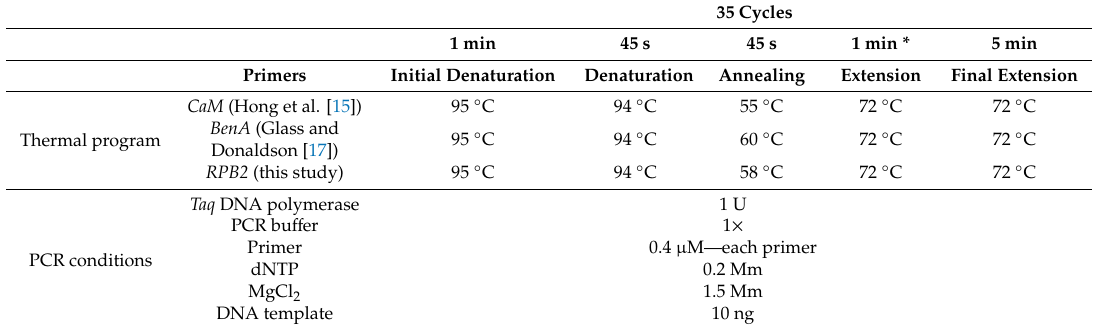
Table 1. Polymerase Chain Reaction (PCR) conditions for CaM, BenA and RPB2